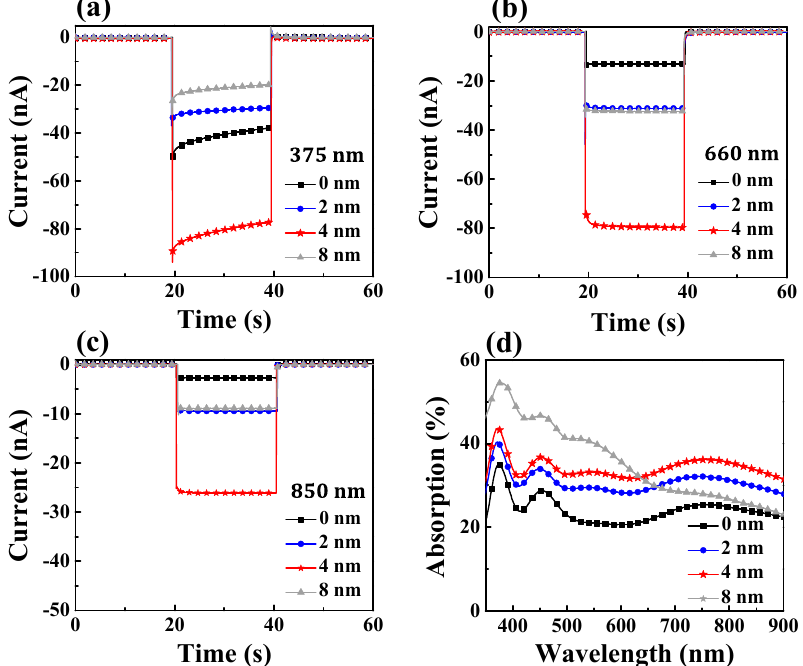
Figure 5. Transient photocurrents of the hybrid plasmonic HEPDs depending on varied Au NPs (by tuning t n =0, 2, 4, and 8 nm) under illumination of 375 nm ( a ), 660 nm ( b ), and 850 nm ( c ) light. ( d ) Measured absorption spectra of the HEPDs with different Au NPs.